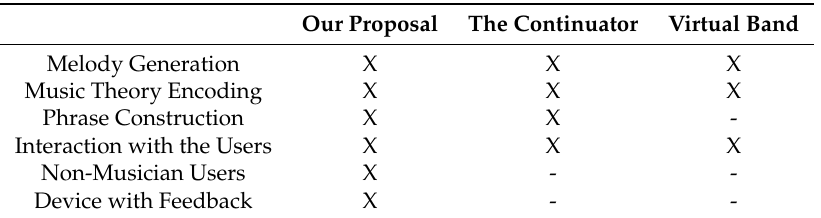
Table 1. Comparison between our proposal and other proposals. Our Proposal The Continuator Virtual Band Melody Generation X X X Music Theory Encoding X X X Phrase Construction Interaction with the